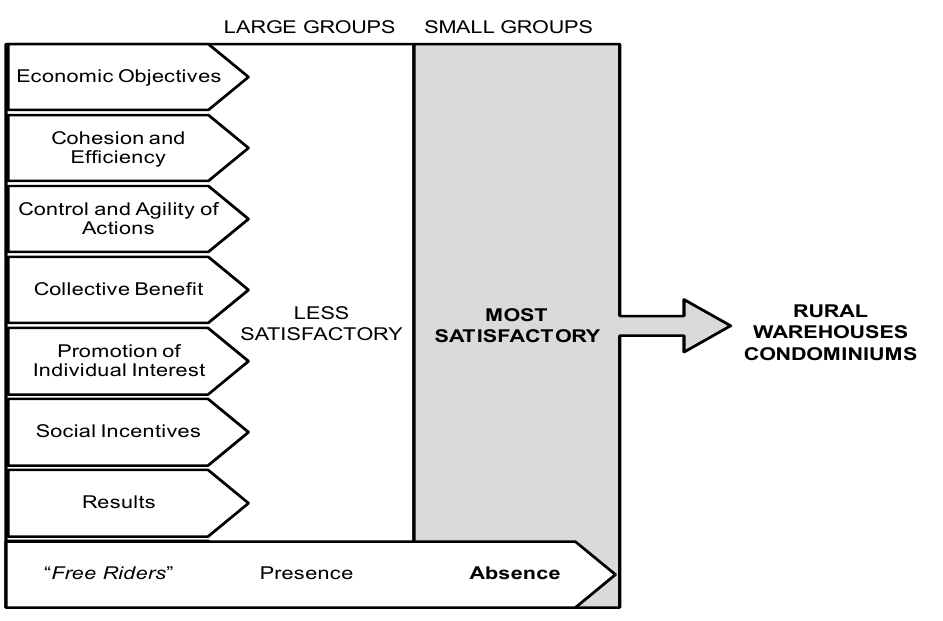
Figure 2. Differences between Small Groups and Large Groups.